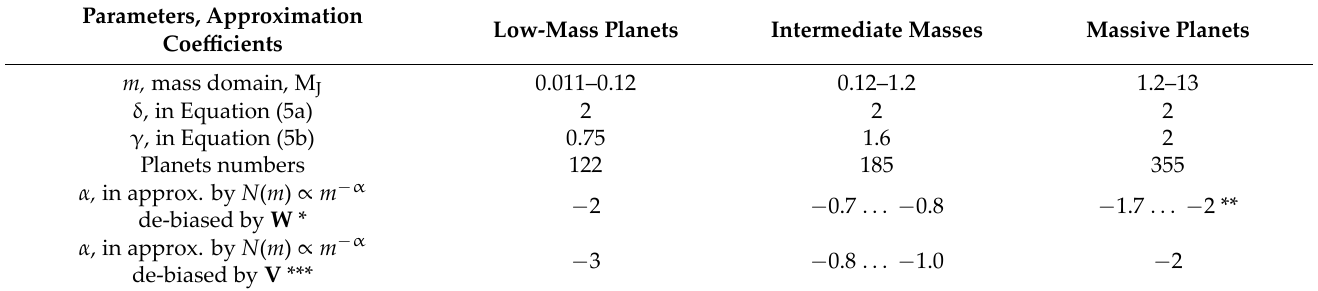
Table 1. Optimal parameters and power law approximation for three mass